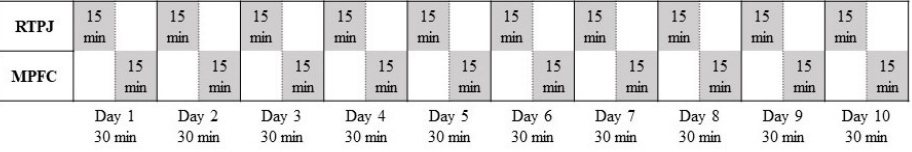
Figure 3. Schematic diagram of the location of stimulation. Abbreviations: RTPJ = right temporo- parietal junction; MPFC = medial prefrontal cortex.